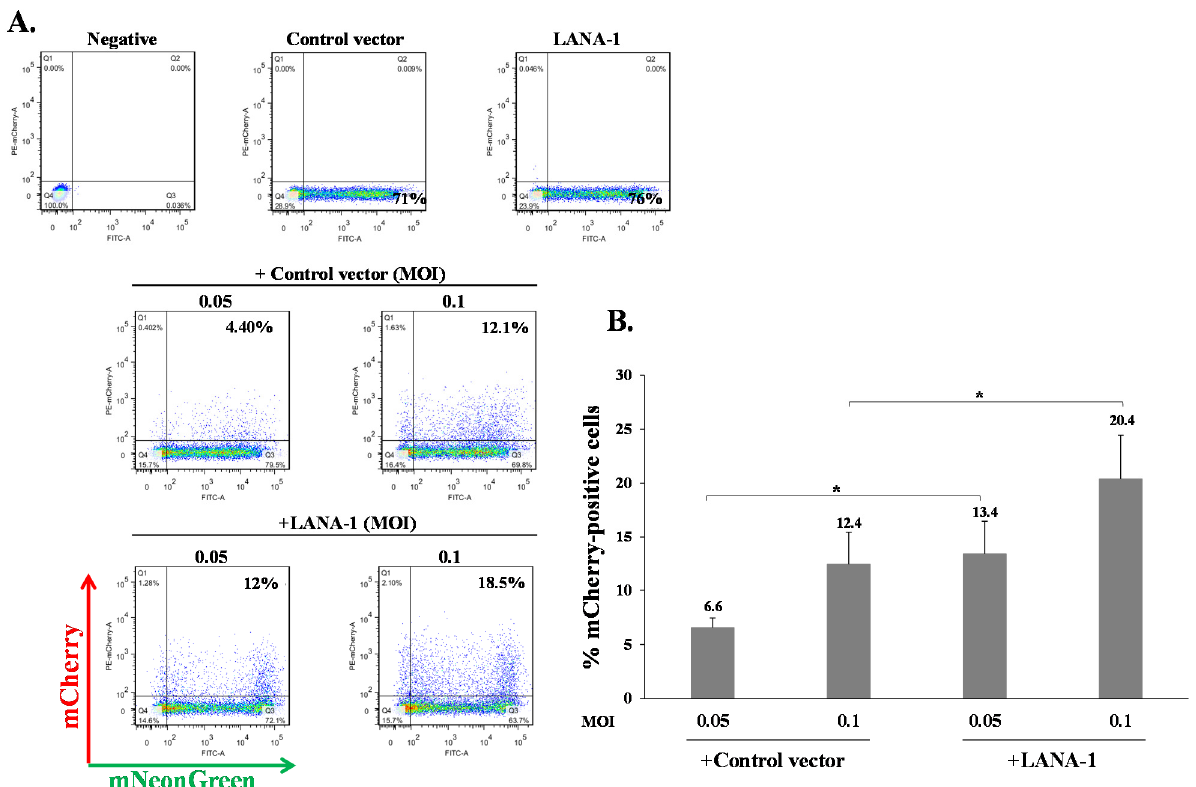
Figure 10. Role of LANA-1 in enhancing latency in HEK-293T. ( A ) HEK-293T cells were transfected with HA-tagged LANA-1 expression plasmid that also expressed ZsGreen fluorescent protein or with control plasmid. After 24 h, the cells were infected with BAC16-mCherry viruses at an MOI of 0.05 and 0.1 using spinoculation. Cells were harvested 48 h after infection, and the percentage of cells expressing mCherry in ZsGreen-positive cells was measured by FACS. The images represent one experiment out of three that demonstrated similar results. ( B ) Percentage of cells expressing mCherry following infection of cells transfected with LANA-1 expression vector or control vector; results shown are the average of three independent experiments. Statistical analysis was performed using the one-way ANOVA test and Tukey’s post hoc analysis tests. * p < 0.05.